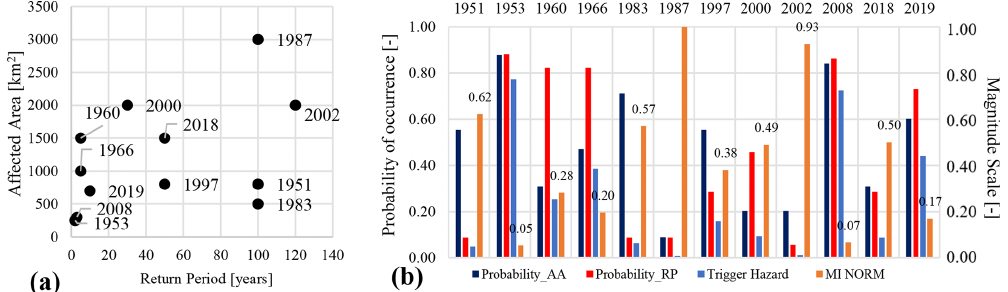
Figure 8. (a) Correlation between RP and AA parameters and (b) determination of the probability of occurrence of AA, the RP, and the trigger hazard for dataset